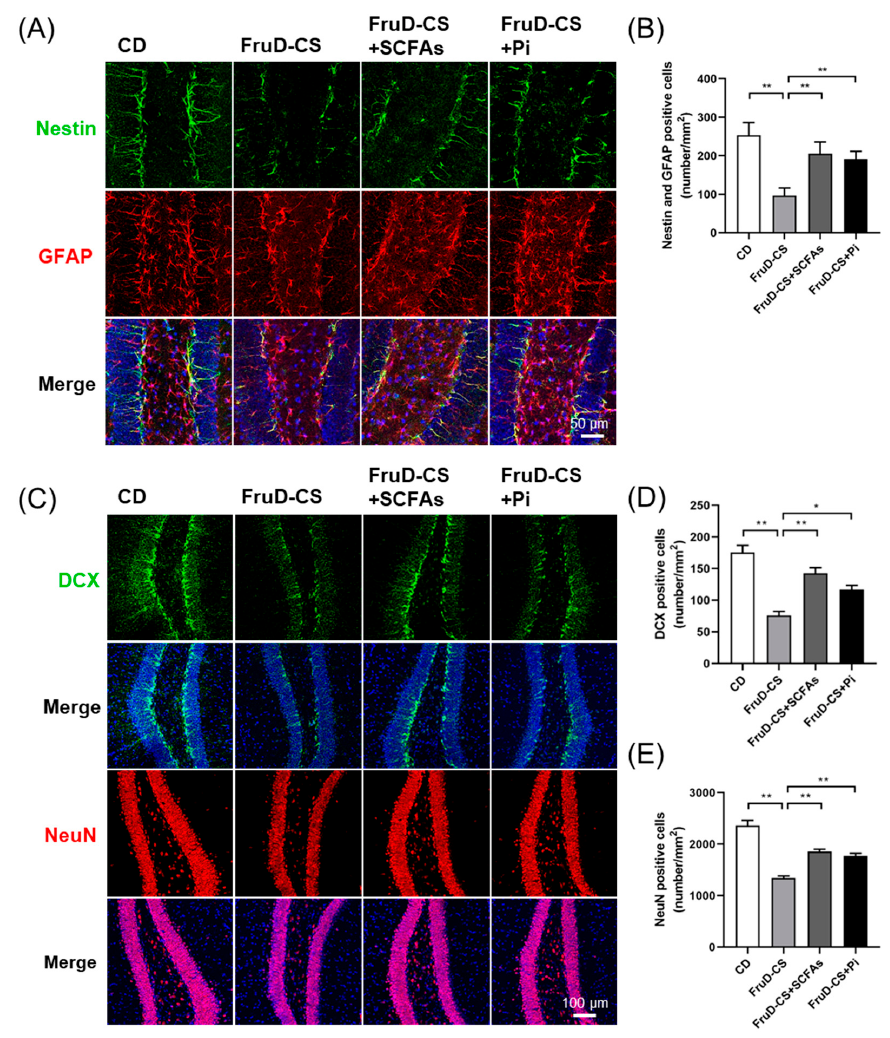
Figure 5. SCFAs and pioglitazone rescued the decline of hippocampal neurogenesis in FruD-CS mice. ( A ) Representative confocal images labeled with Nestin and GFAP. ( B ) Number of Nestin and GFAP positive NSCs was quantified. ( C ) Representative confocal images labeled with DCX or NeuN. ( D ) Number of DCX positive newborn neurons was quantified. ( E ) Number of NeuN positive mature neurons was quantified. Data are expressed as mean ± SEM, * p < 0.05, ** p < 0.01.